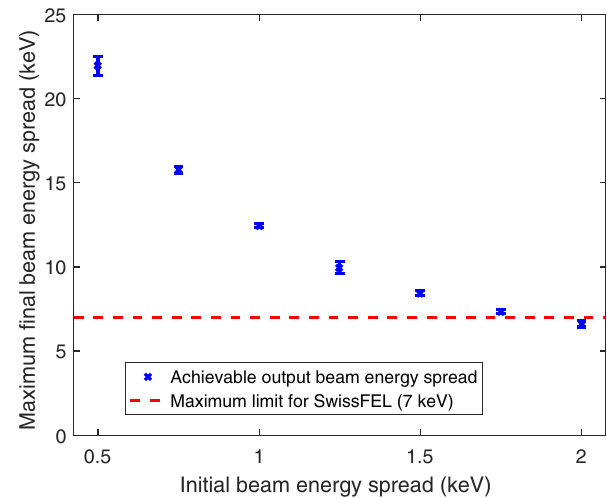
FIG. 4. Achievable beam energy spread as a function of the initial beam energy spread.